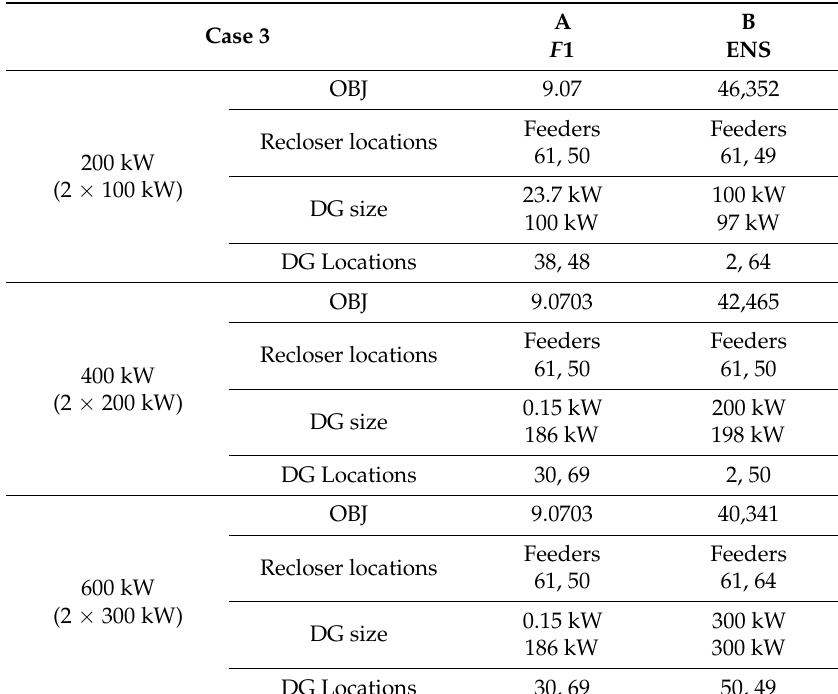
Table 5. System indices versus different methodologies (A and B).